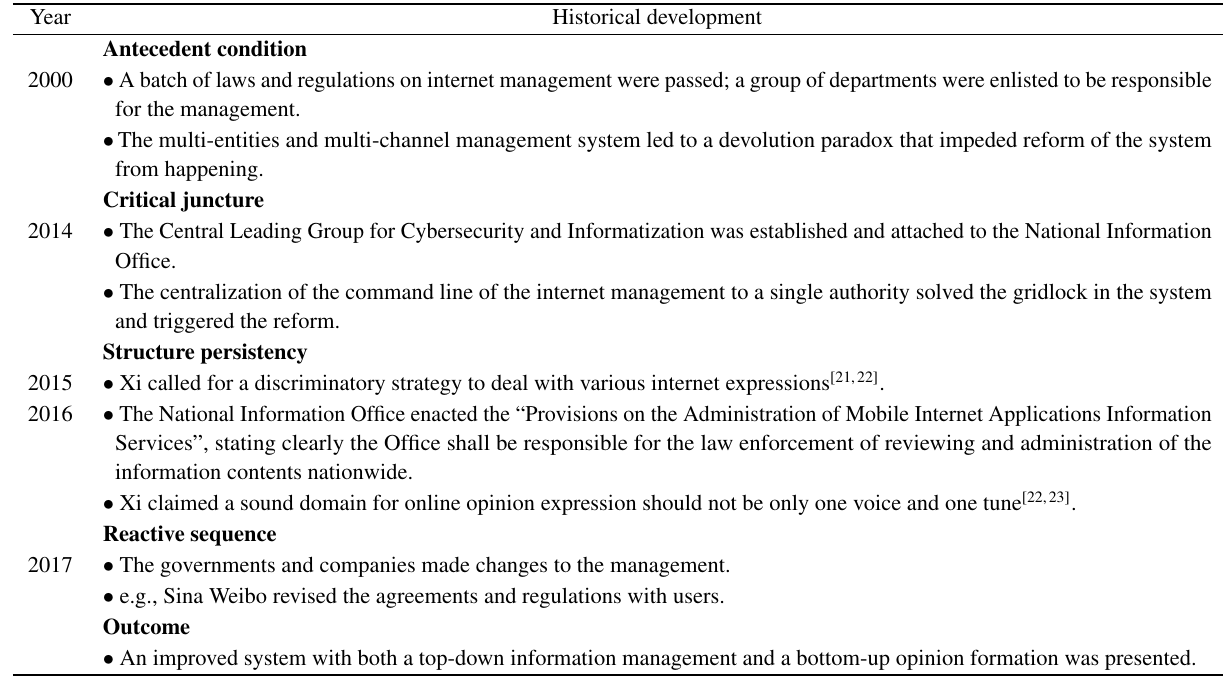
Table 1 Historical institutional analysis of the reform of Chinese internet information management